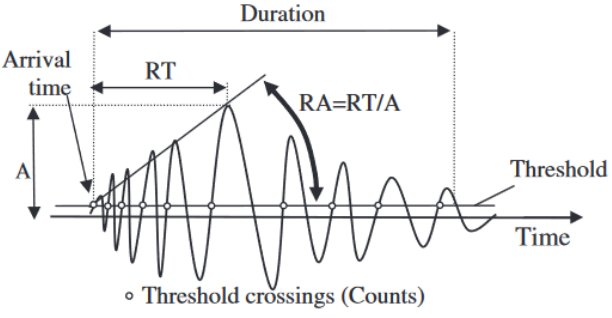
Figure 7. Definitions of AE characteristic parameters [28].